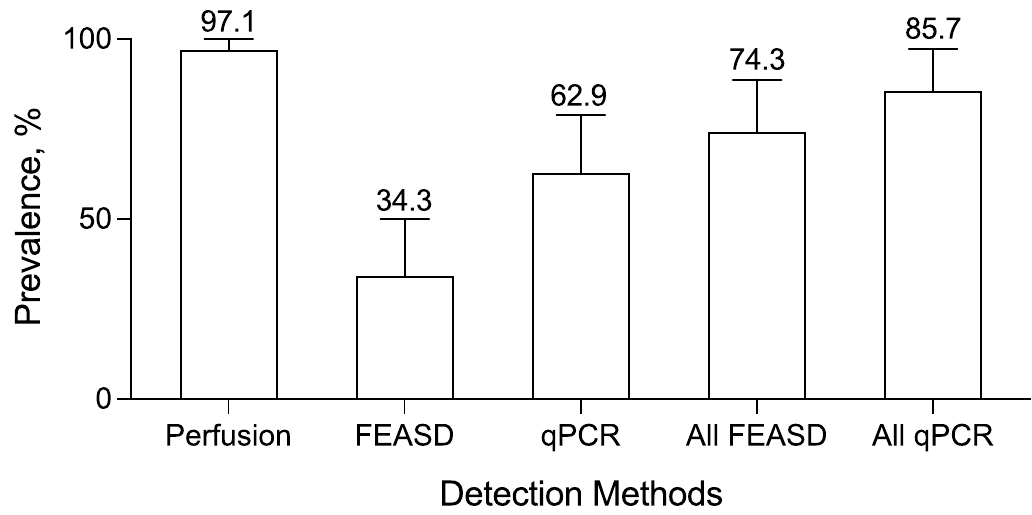
Fig 3. High prevalence of schistosomiasis japonica in water buffalo as assessed by animal perfusion in comparison to coprological techniques. S. japonicum prevalence by perfusion (n = 34) of adult worms from the mesenteric veins at 10 months post-exposure, in comparison to coprological FEASD (n = 35), and qPCR (n = 35), techniques. Error bars represent 95% confidence